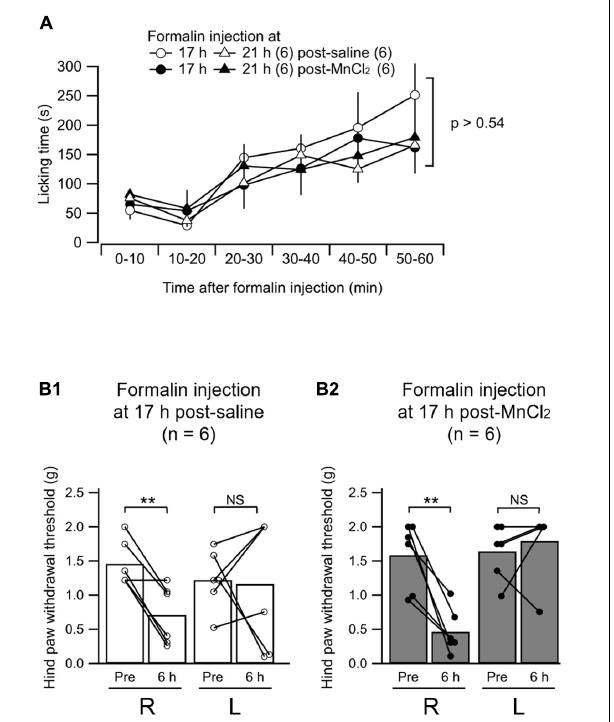
FIGURE 7 | Formalin-induced nociceptive behavior. (A) Summary of the time course of the licking behavior after intraplantar injection of formalin (5%) in to the left hind paw. The open and filled markers indicate the responses recorded in mice with intravenous administration of saline and MnCl 2 , respectively. Circles, 17 h after administration (post-saline, n = 6; post-MnCl 2 , n = 6); triangles, 21 h after administration, (post-saline, n = 6; post-MnCl 2 , n = 6). Mean ± SEM. ANOVA followed by post hoc Gabriel’s test. Numbers in parentheses indicate the number of mice. (B1,B2) Summary of the paw withdrawal threshold as measured with von Frey filaments at 6 h after intraplantar injection of saline (B1) or formalin (B2) to the left hind paw. R, values from the right hind paw; L, values from the left. Pre, measurement at 2 h before intraplantar injection; 6 h, that at 6 h after injection. The bars show the mean and the markers show the values from each mouse. P < 0.005; NS, not significantly different; paired t